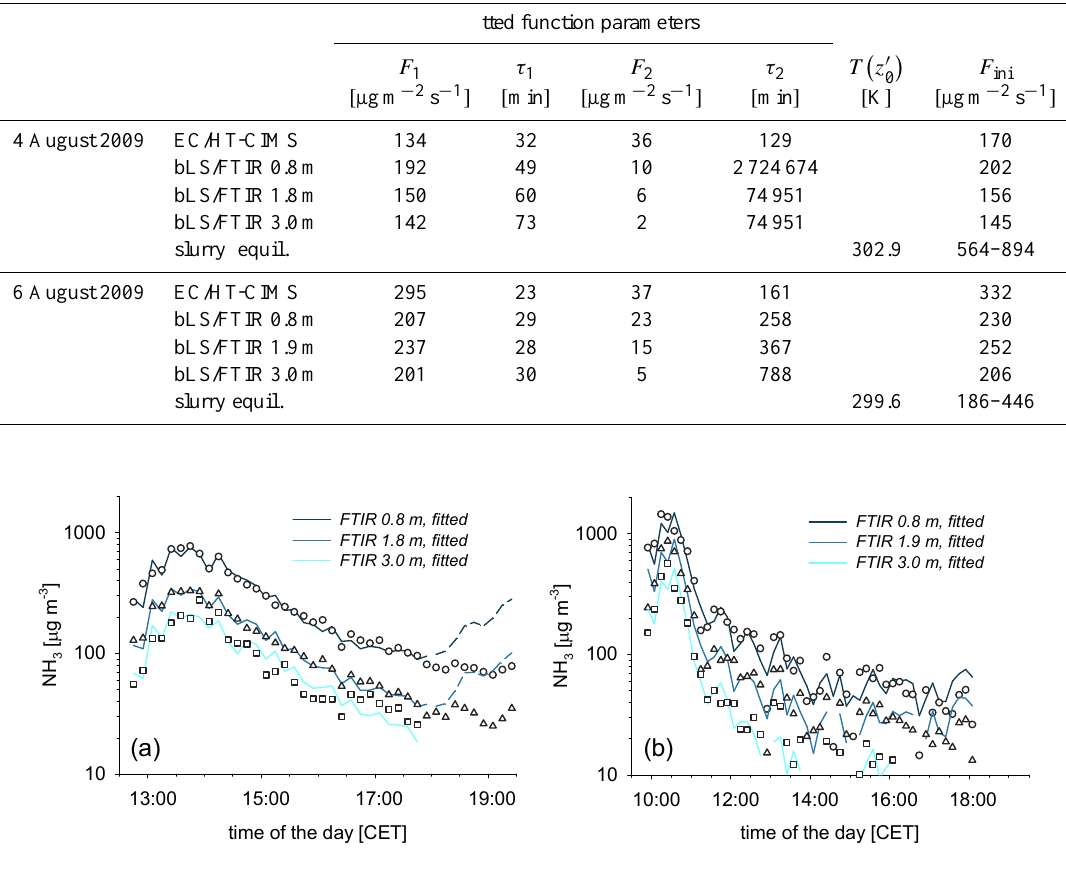
Table 3. Parameters of the best-fitted bi-exponential functions, calculated surface temperature ( T (cid:0) z 0 ( F ini ) as derived from Eq. (2) and as expected from initial slurry equilibrium conditions.